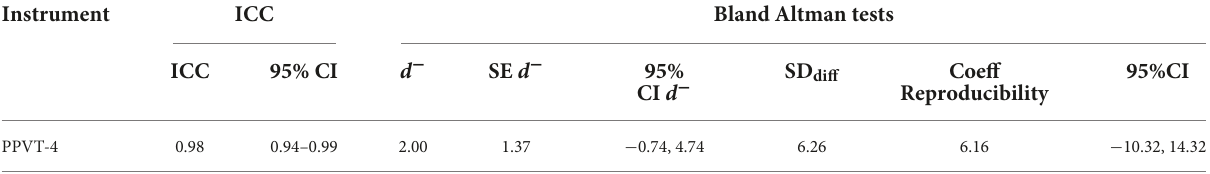
TABLE 2 Repeatability and measurement of agreement: intraclass correlations and Bland Altman test results in pooled sample ( n = 21). Instrument